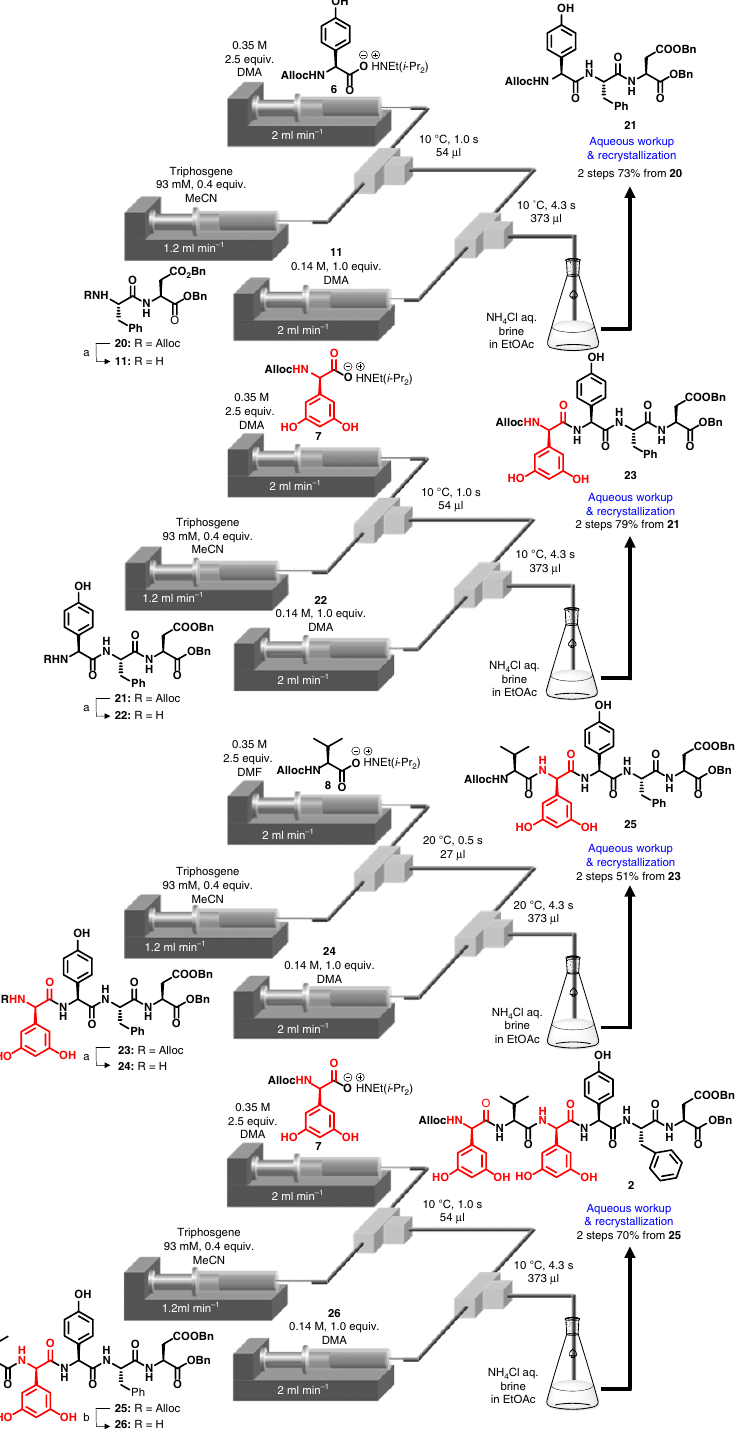
Figure 3 | Synthesis of C-terminal hexapeptide 2 using micro-flow amidation. Conditions: ( a ) Pd(PPh 3 ) 4 , PhSiH 3 , CH 2 Cl 2 /MeOH, r.t., 1–1.5h, batch. ( b ) PS-Ph 3 P-Pd, PhSiH 3 , CH 2 Cl 2 /MeOH/H 2 O, r.t., 1h,